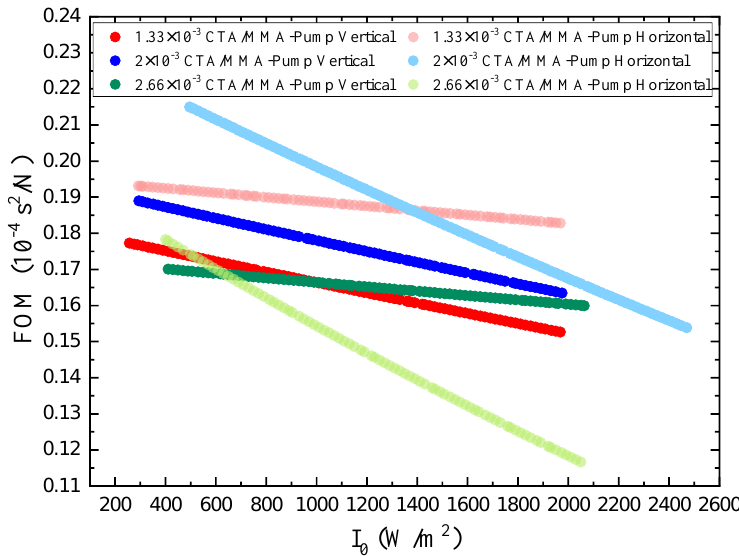
Figure 18. Figure of merit as a function of intensity for fibers with different CTA concentrations and measured for two orthogonal polarizations. The result is derived from the intensity-dependant photomechanical response κ ( 1 ) ( I 0 ) and the intensity-dependent Young’s modulus E ( I 0 ) , given by Equation